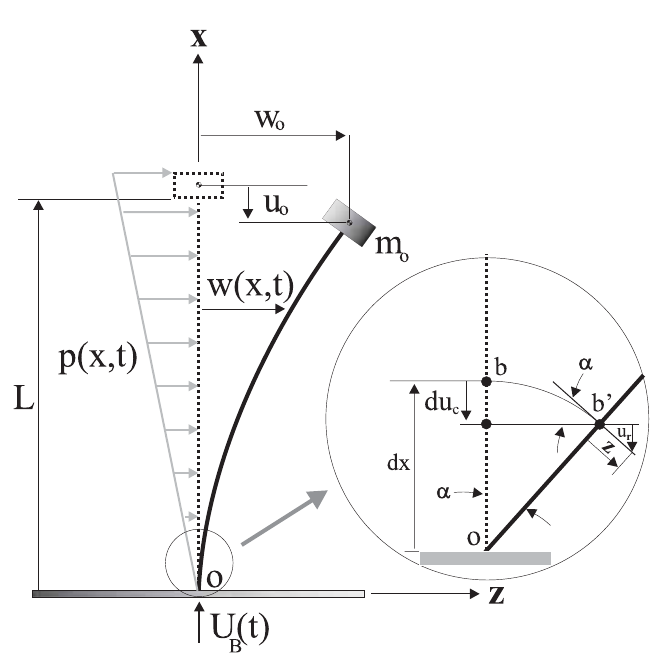
Fig. 1. Physical system under investigation: (a) frontal view; (b) lateral view.